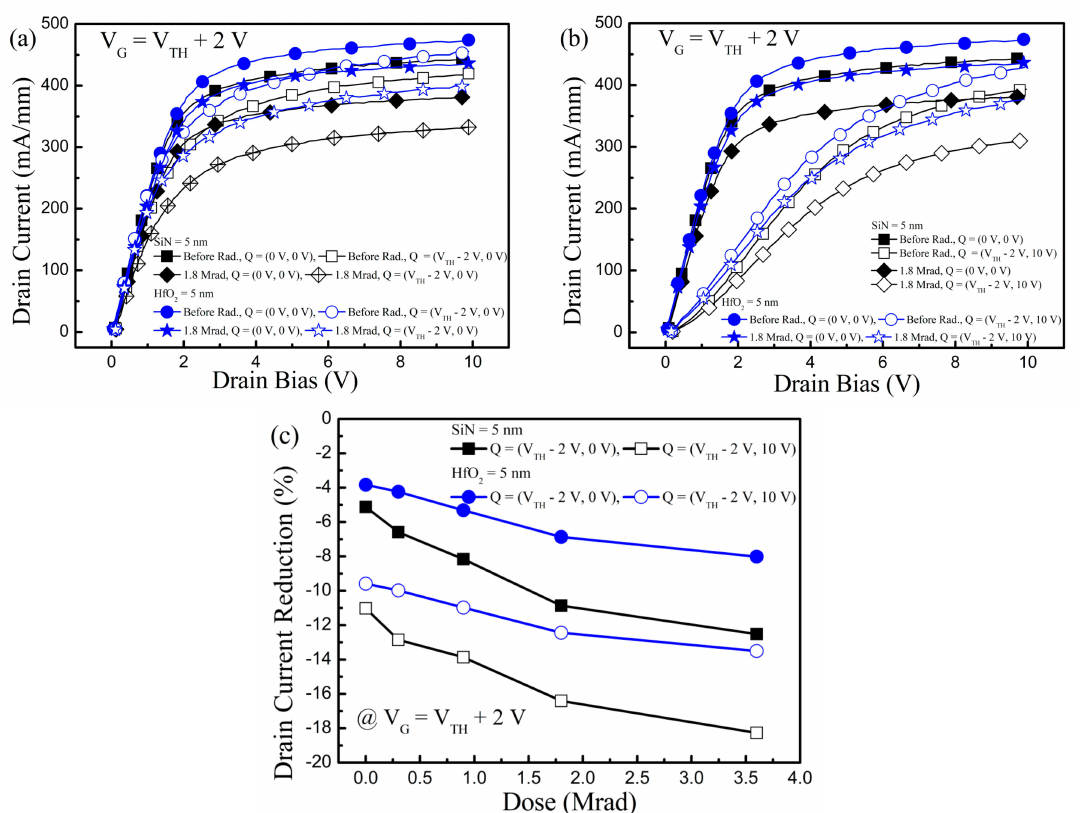
Figure 5. Pulse-mode stress measurement results. Drain current as a function of drain bias with the quiescent bias of: ( a ) (0 V, 0 V) and ( V TH − 2 V, 0 V); ( b ) (0 V, 0 V) and ( V TH − 2 V, 10 V) before and after γ -ray radiation with the irradiated doses of 1.8 Mrad. ( c ) Drain current reduction from the quiescent bias of (0 V, 0 V) caused by the pulse-mode stress with the quiescent bias of ( V TH − 2 V, 0 V) and ( V TH − 2 V, 10 V) vs. irradiated γ -ray